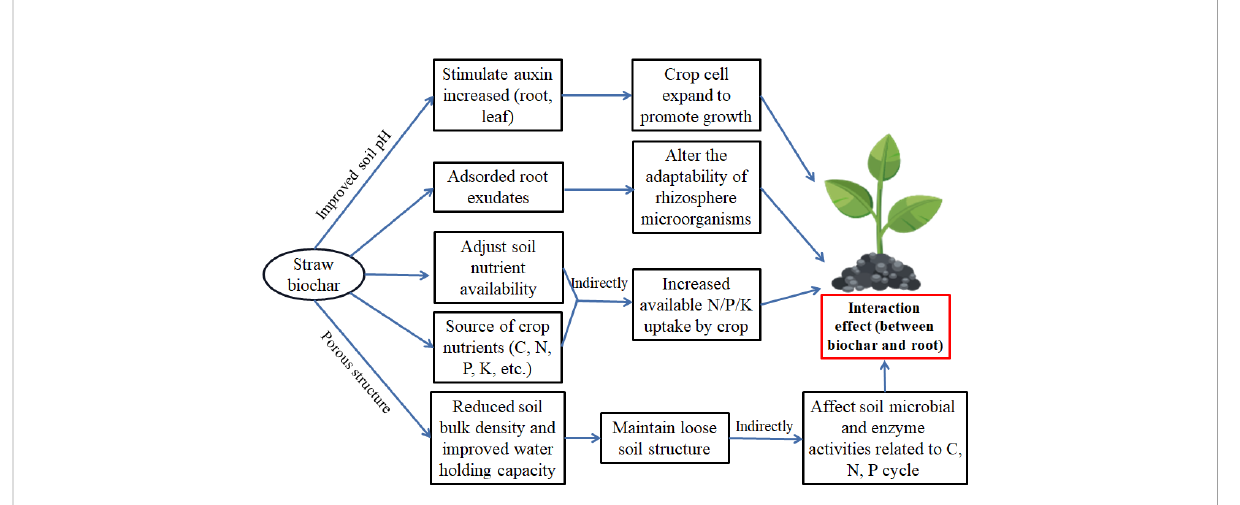
FIGURE 3 Straw biochar return impact in soil for crop